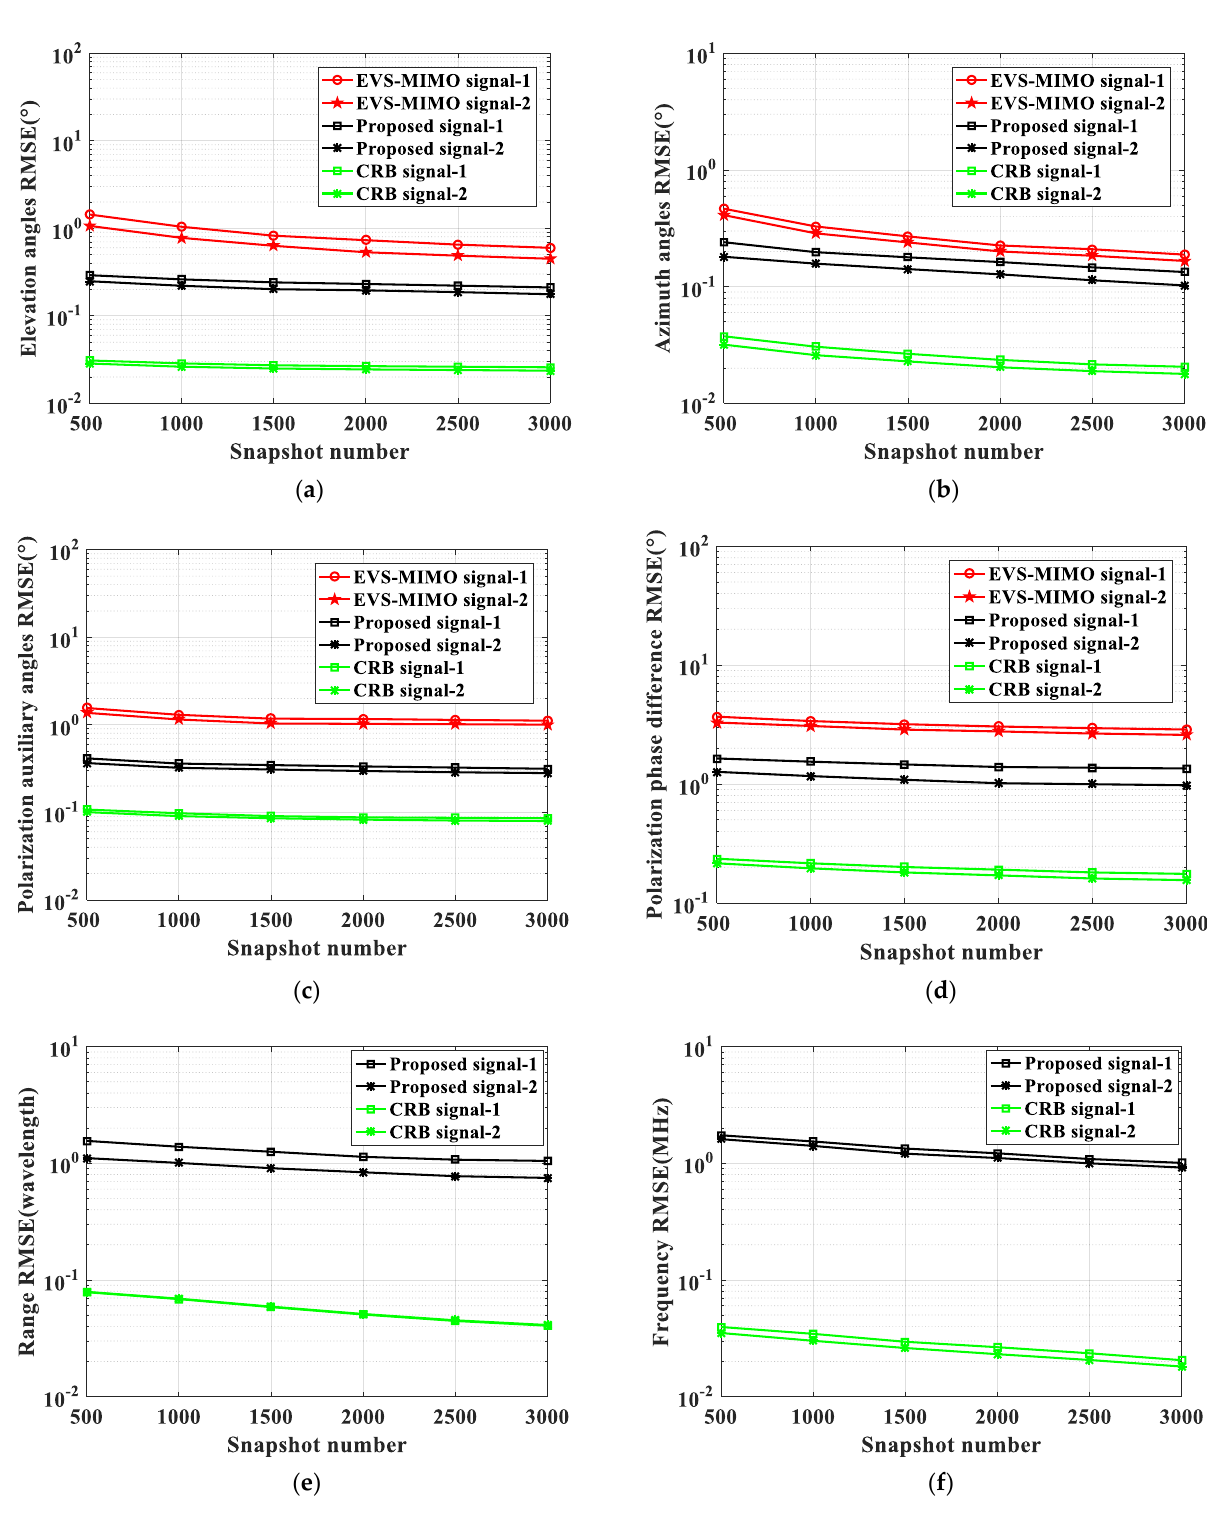
Figure 3. RMSE of the parameter estimation for NF sources with respect to different input